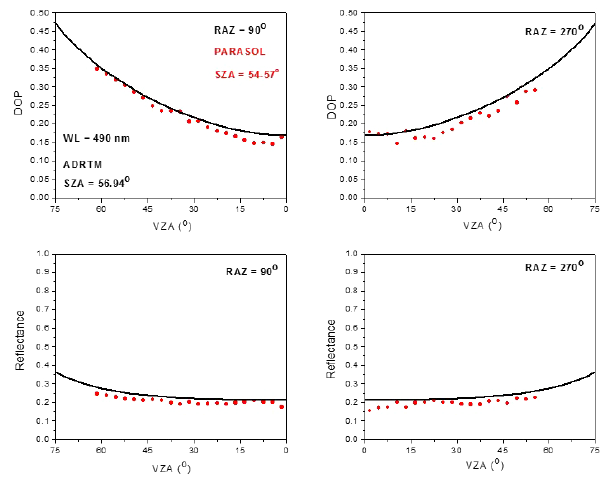
Figure 6. Same as in Fig. 5 but at RAZs of 90 and 270 ◦ .